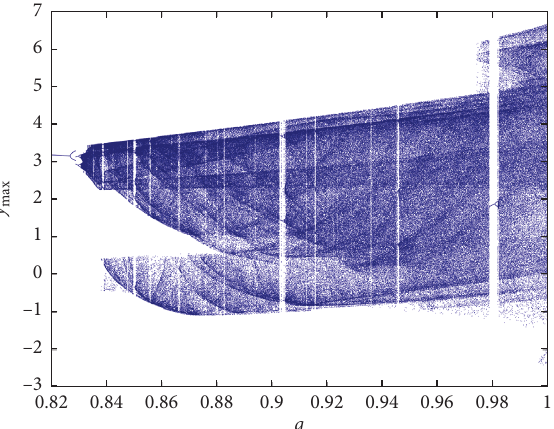
Figure 3: Bifurcation of the FOPLL system for K � 2.6 and G � 1 for various values of commensurate fractional order q